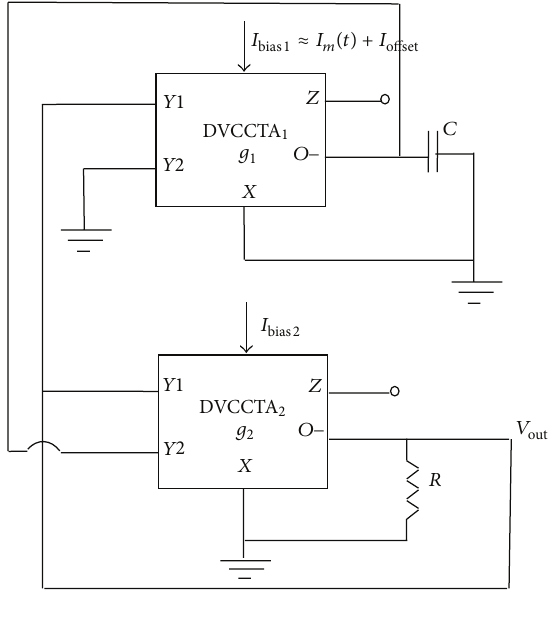
Figure 5: Proposed AM modulator. Figure 6: Proposed FM modulator.